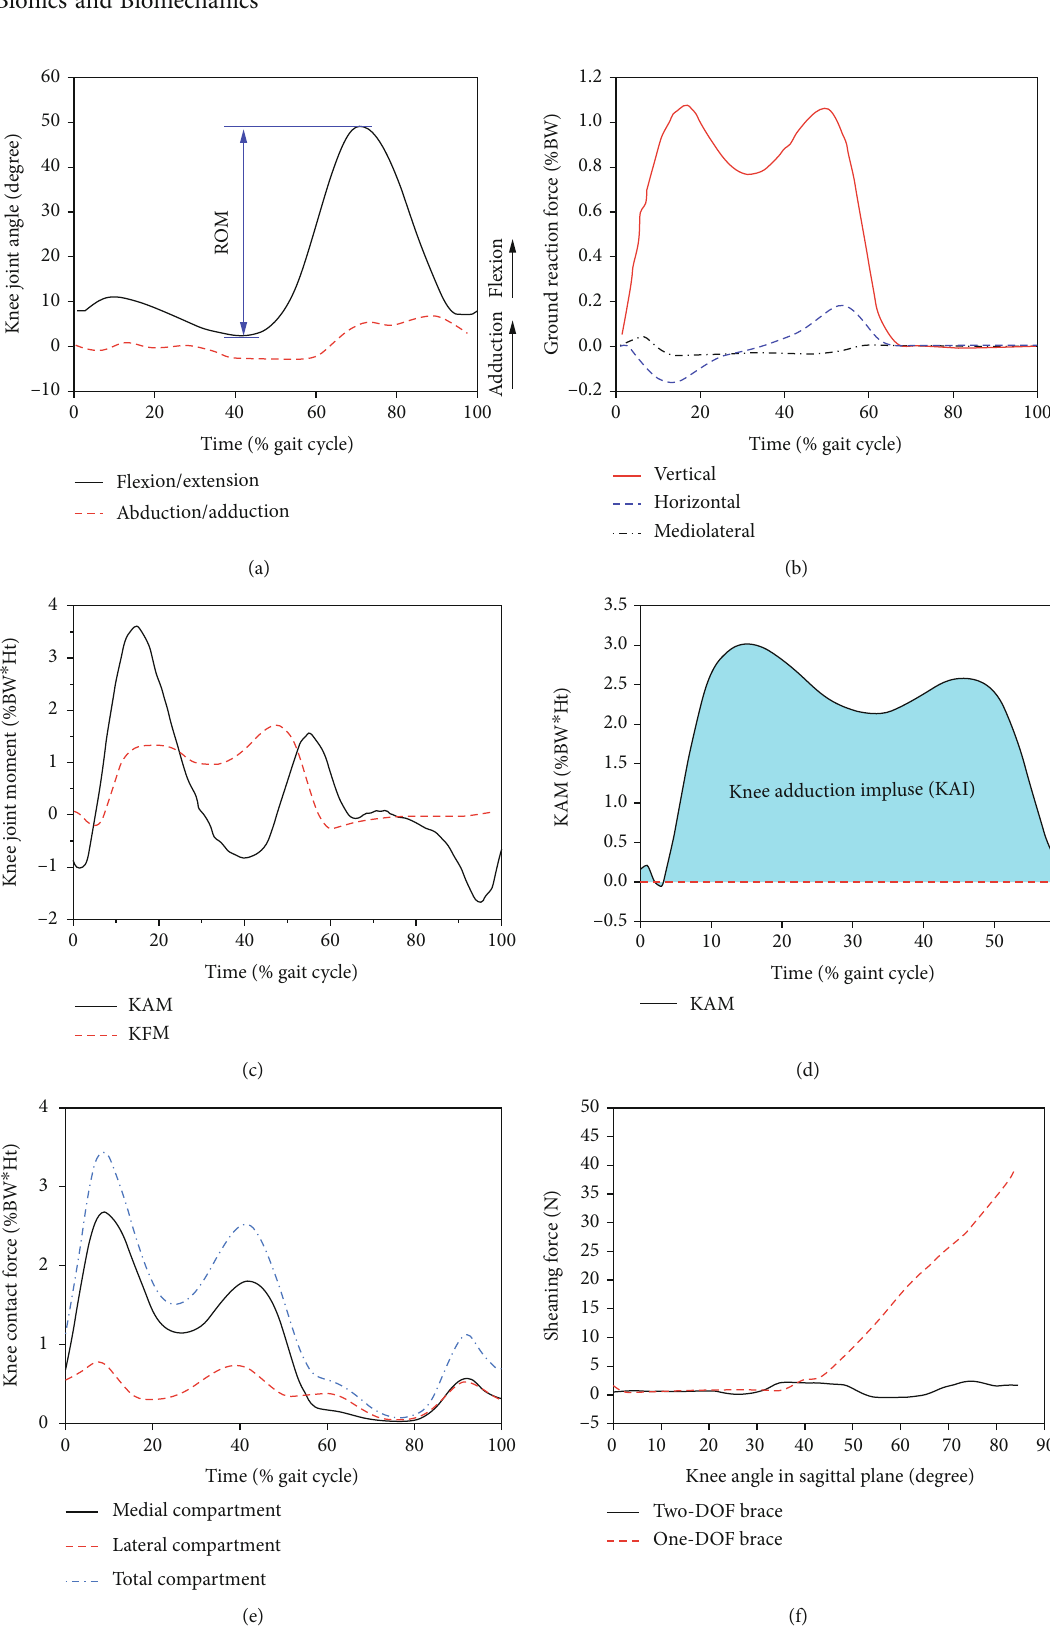
Figure 5: Kinematic and kinetic description of gait. (a) Knee joint angle and knee range of motion (ROM). (b) Ground reaction force [38]. (c) Knee adduction moment (KAM) and fl exion moment (KFM). (d) Knee adduction moment impulse (KAI). (e) Knee joint contact force [21]. (f) Shear force between the brace and human [24], DOF: